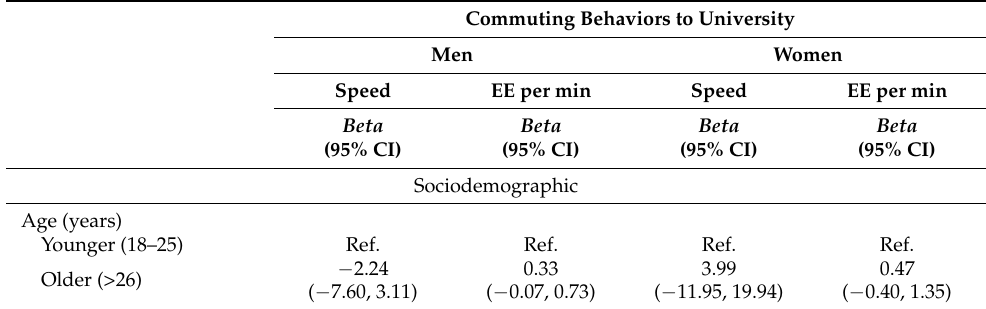
Table 3. Associations between commuting behaviors with sociodemographic characteristics in university students by